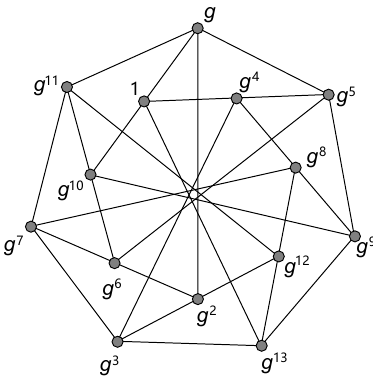
Figure 1: The Cayley graph in C 14 generated by { g ± 1 , g ± 4 } .